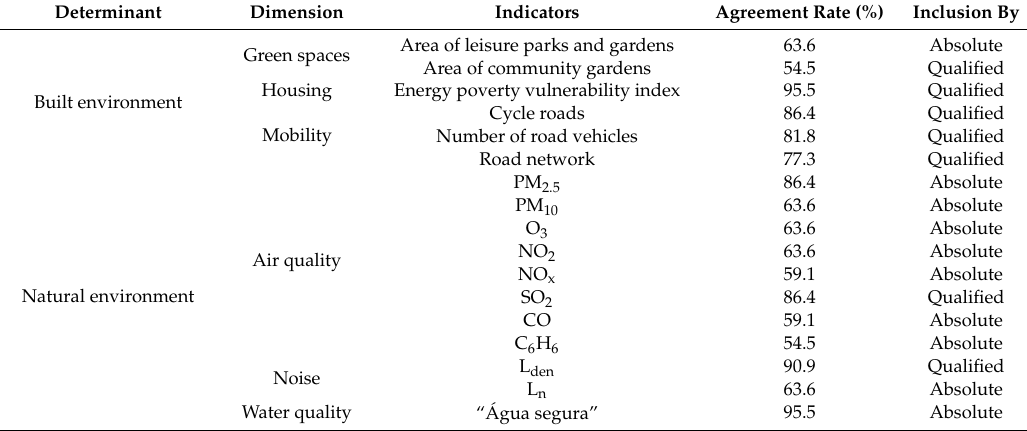
Table 3. Indicators approved by majority decision rules after the second round, grouped by built and natural environment